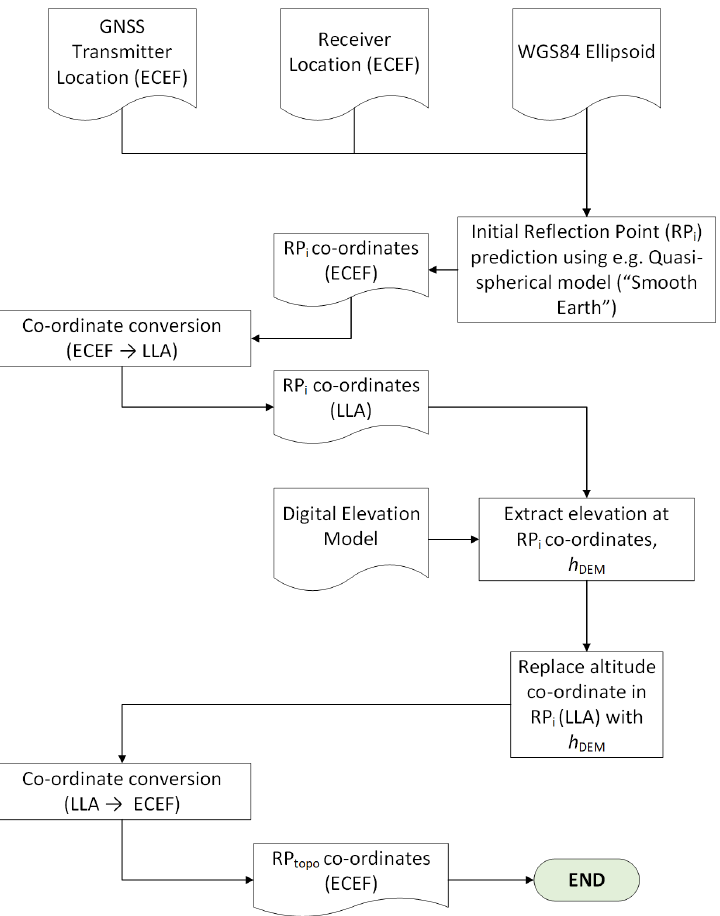
Figure 4. Diagram of the baseline version of the Topographically Accurate Reflection Point Prediction algorithm (TARPP